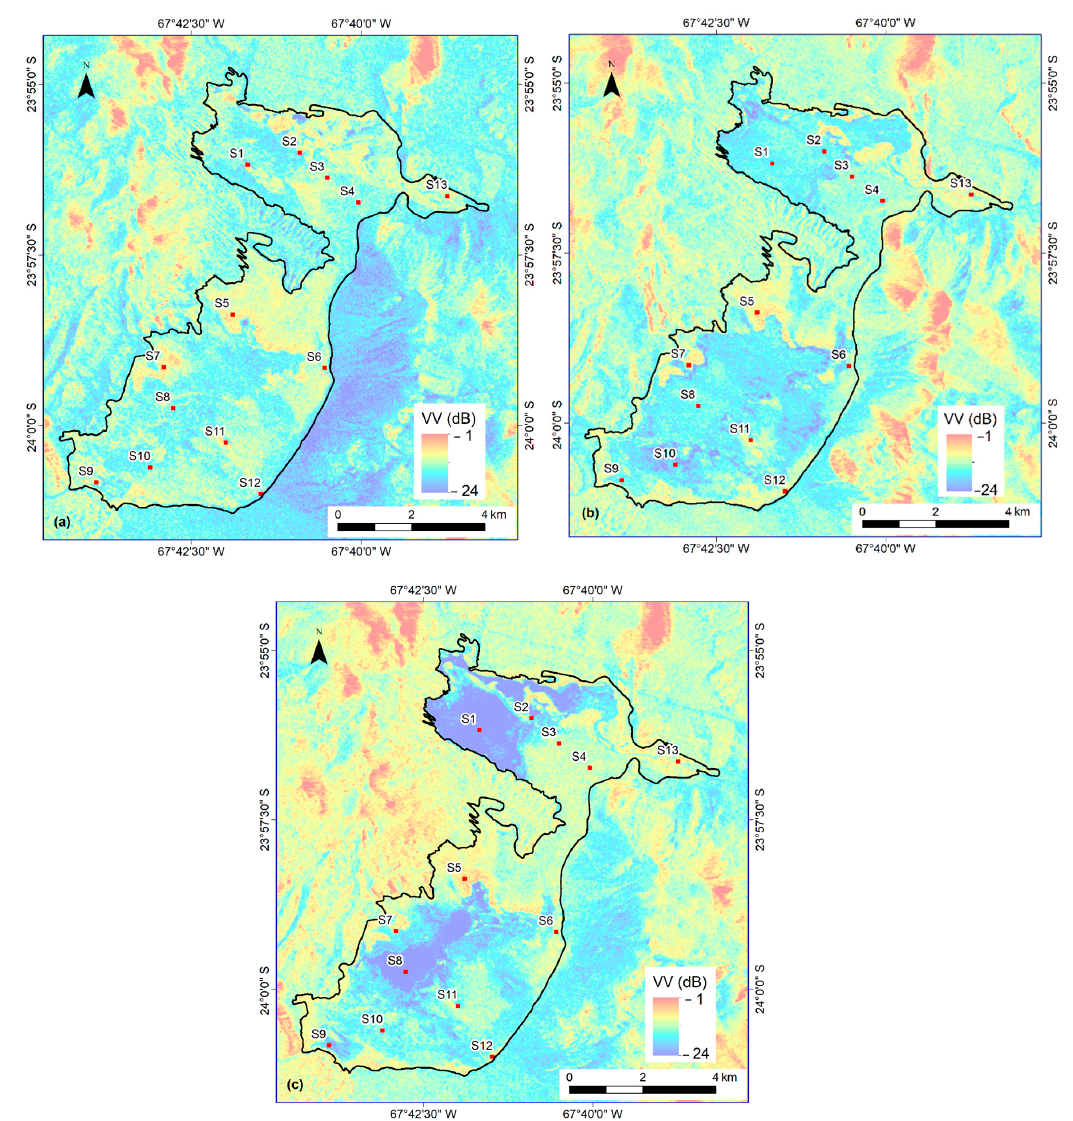
Figure 10. ( a ) Sentinel 1-B, VV polarization, descending orbit (27 May 2017). The salar surface is fully covered by snow, ( b ) Sentinel 1-B, VV polarization, ascending orbit (11 September 2017). Flooding event following the snow melting with wind-generated roughness over the water beds. ( c ) Sentinel 1-B, VV polarization, descending orbit (7 September 2018). No-wind condition: Low backscattered power from standing water over sites S1, S8, and S9. Note the similar flooding extents between ( b ) and ( c ). Other σ 0 variations are summarized in Table 3 for those sites with monthly rates greater than 1.00 dB. Rates are computed as the ratio of the interval to month on a 30-day month basis. For sites 1, 10 and 6 a large growth rate is found over the dry period after the snowfall at the beginning of the time series. When the water input is in the form of rainfall, as in February 2018, the halite growth rate that followed drops by about one half on sites 1 and 10. On site 11 and 4, the influence of precipitation type on the rate seemed not so marked. Thus, the e ff ect of water droplets dissolving previously grown salt aggregates has di ff erent impacts on σ 0